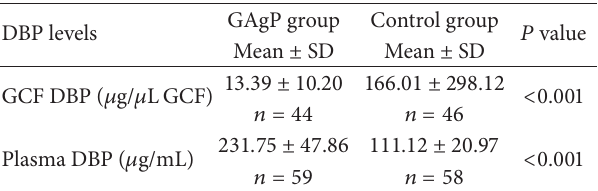
Table 2: Comparisons of GCF DBP levels and plasma DBP levels between GAgP patients and healthy controls.